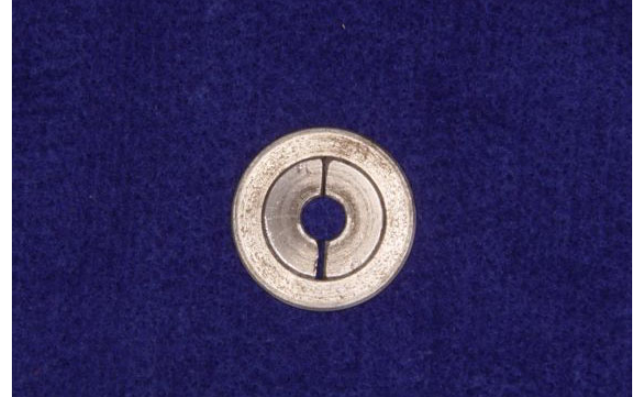
Fig. 2: Metal matrices assembled.